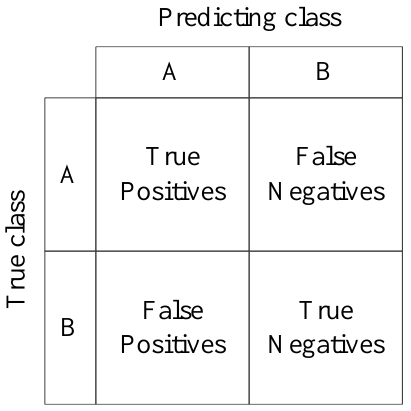
Figure 3. Schematic diagram of classification confusion